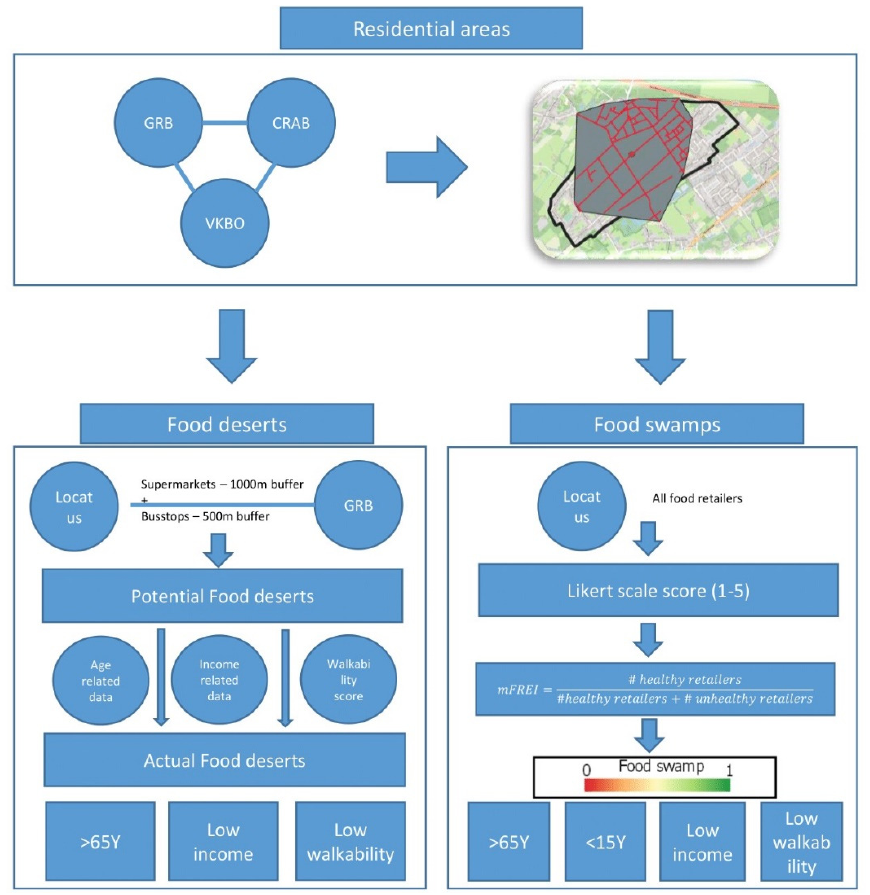
Figure 2. Technical roadmap of the research. Firstly, the residential areas in Flanders are identified. Secondly, the food deserts and food swamps are determined within these residential areas.